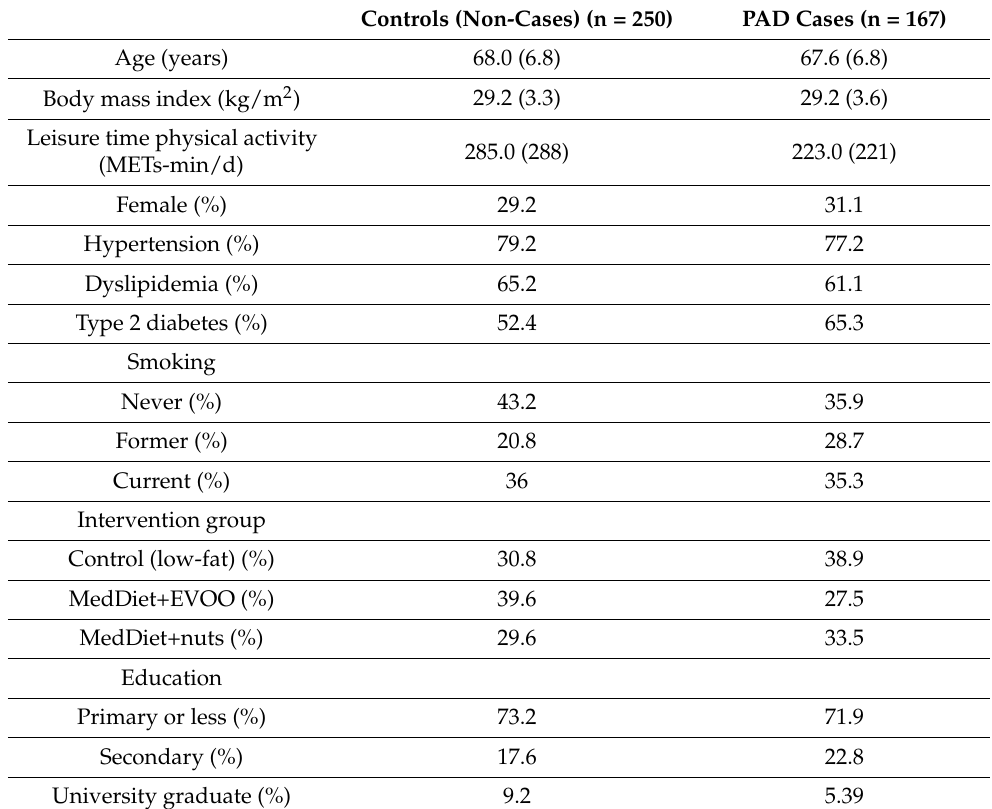
Table 1. Baseline characteristics of the participants according to the incidence of peripheral artery disease